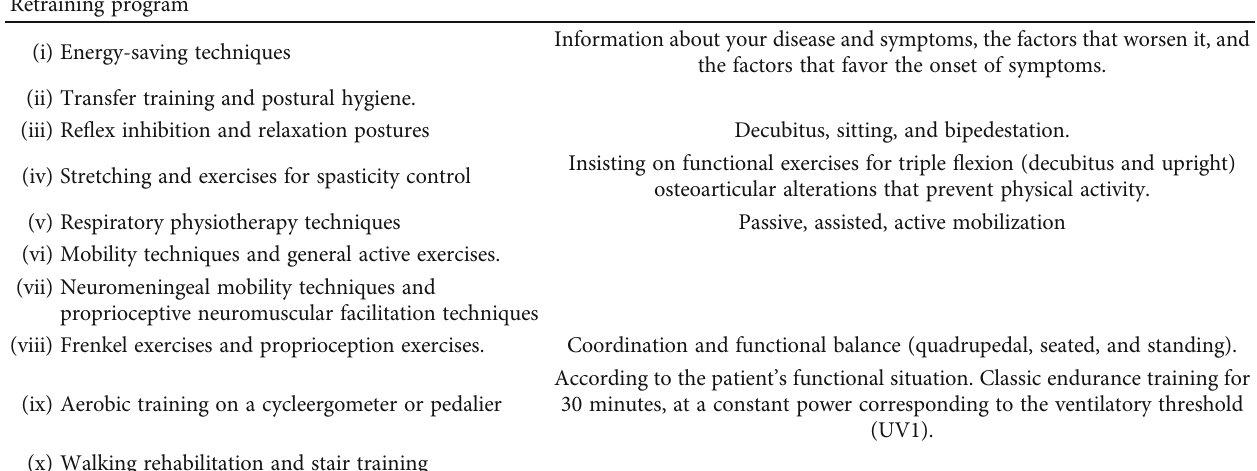
Table 1: Retraining